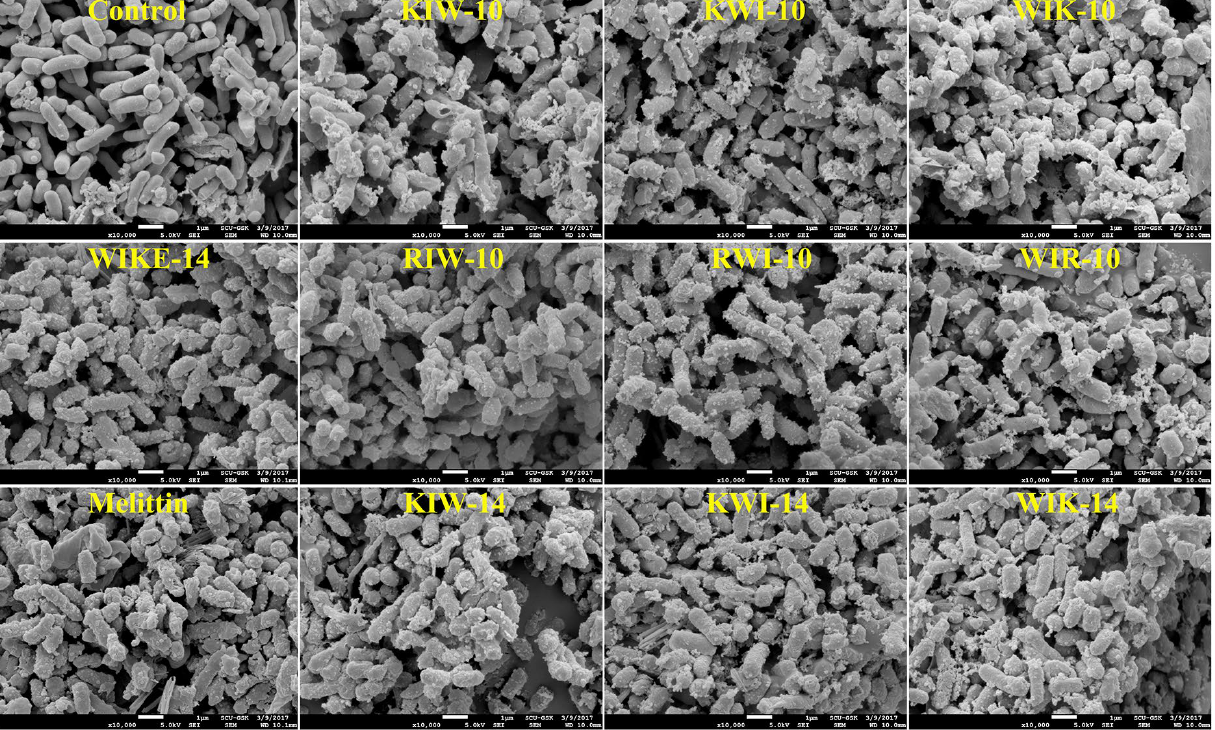
Figure 7. Peptide-induced morphological changes in E. coli cells. All peptides were treated at minimum inhibitory concentrations (MICs).